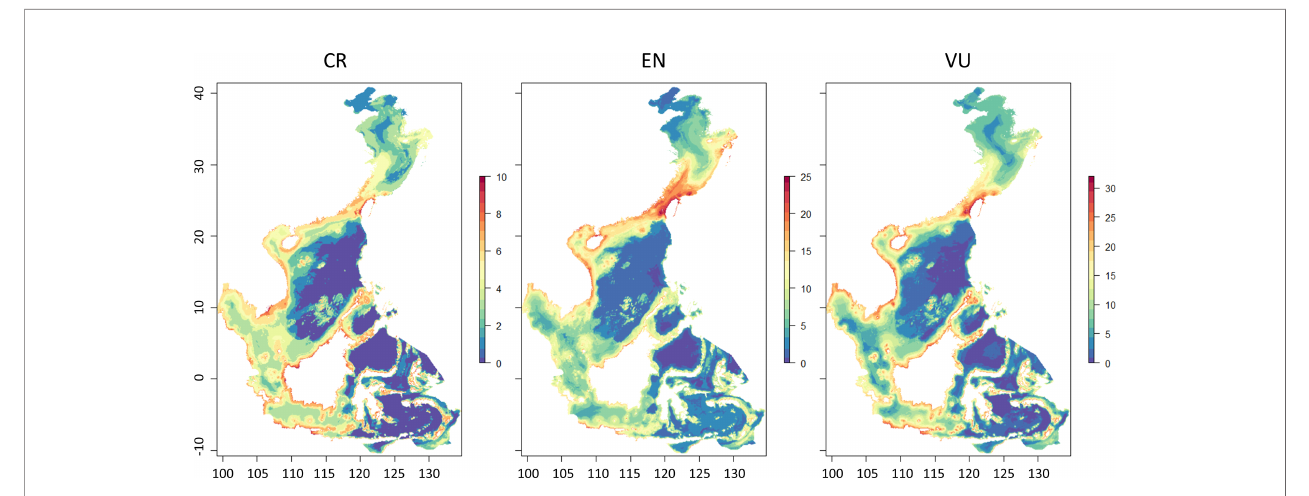
FIGURE 5 | Species distribution of the different ETP